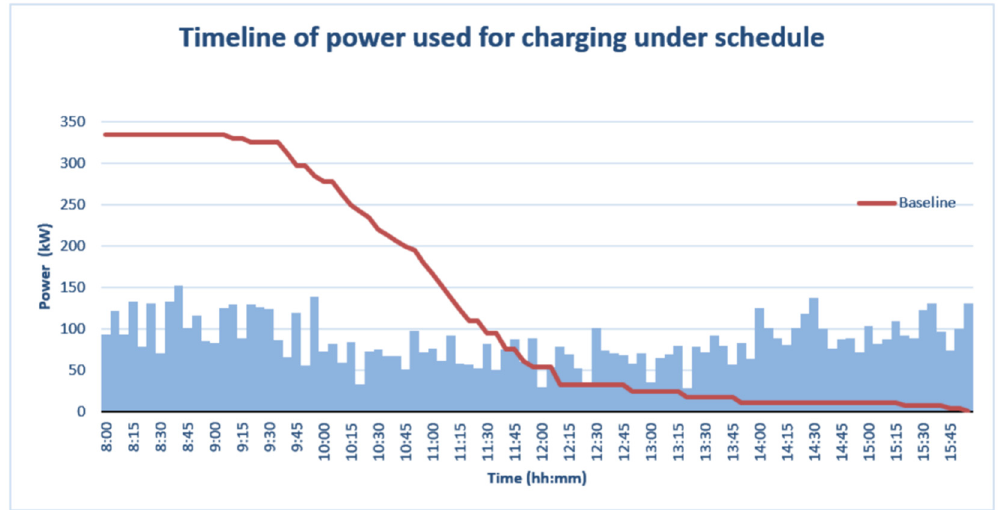
Figure 7. Scenario 2 results.